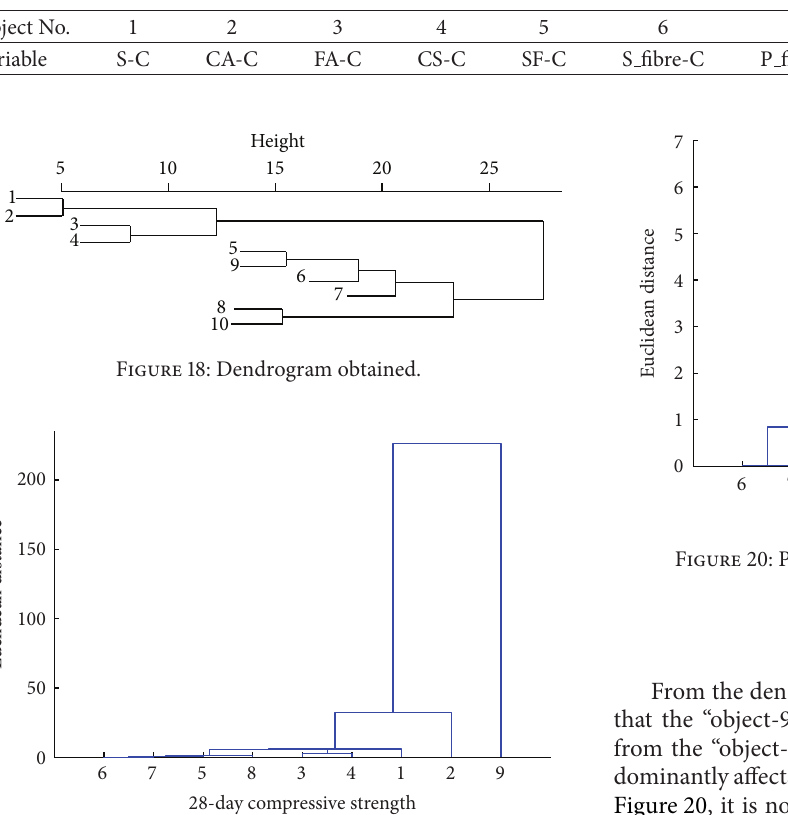
Table 7: Objects and Object number.